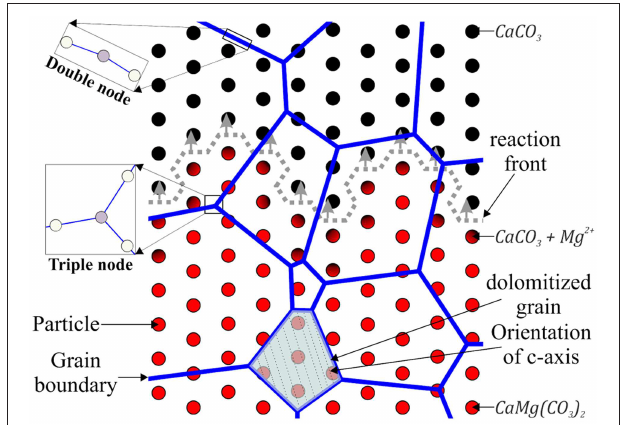
FIGURE 2 | Schematic section of the model showing the basic elements used to simulate the dolomitization and the grain growth. The nodes which are distributed on a hexagonal lattice build up the background of the simulation. The nodes have a value of Mg 2 + -concentration and the parameters of the second-phase (radius and densities) assigned to them. The later influences the migration rate of the grain boundaries. The top layer is built up by the boundary model consisting of connected nodes (either double or triple) which represent the grains. Only grains which are dolomitized can grow whereas the driving force for migration is derived from the surface energy, which is a function of the orientation of the c -axis of the considered crystal and the adjacent